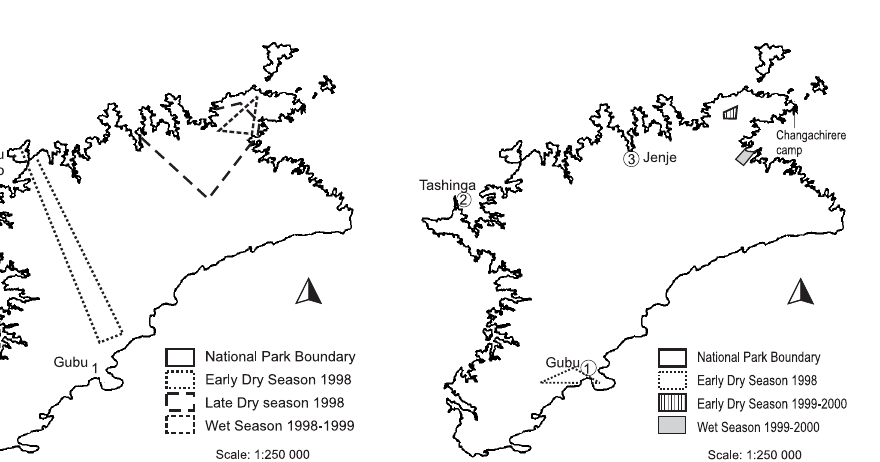
Fig. 4. Map of MNP indicating seasonal ranges of a hand-raised rhino, ‘Pfumbe’. 1-3 = Release sites 1-3.